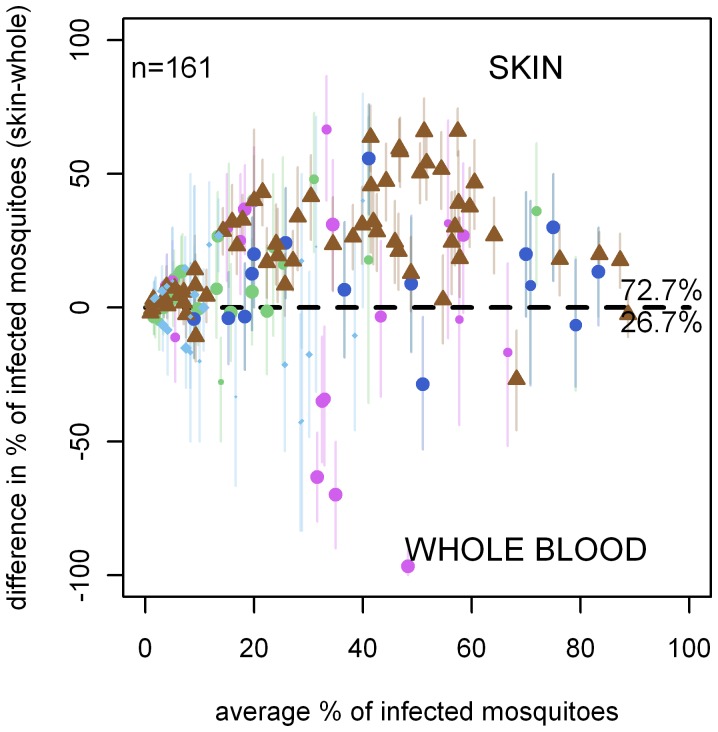
Skin feeding versus membrane feeding.Results are from 161 paired experiments plotted in a Bland-Altman plot. Points above the line had higher infectivity in the skin feeding assay than the whole blood SMFA. Point colour denotes the study using the same key as in Figure 2. The shape of the point denotes the country the experiment was carried out in, be it Cameroon (circle), Mali (triangle) or Senegal (diamond). The size of the points indicates the relative average number of mosquitoes dissected in the experiment, with points>50 mosquitoes dissected having the same size). In 117 experiments (72.7%), the proportion of infected mosquitoes was higher in skin feeding assays compared to the paired whole blood membrane feeding assay; in 43 experiments (26.7%) the opposite was observed.